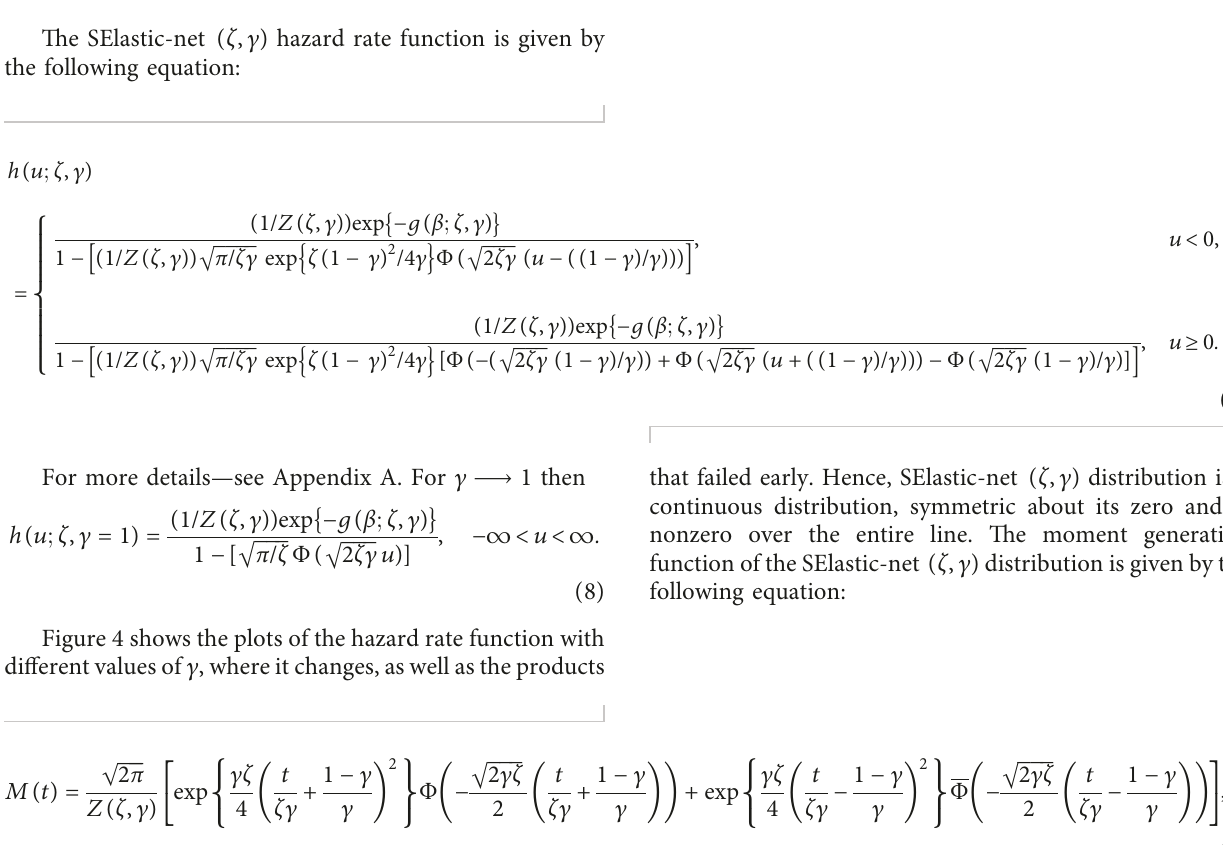
Figure 3: Plots the cumulative function of SElastic-net ( ζ , c ) with ζ � 1 and different values of c